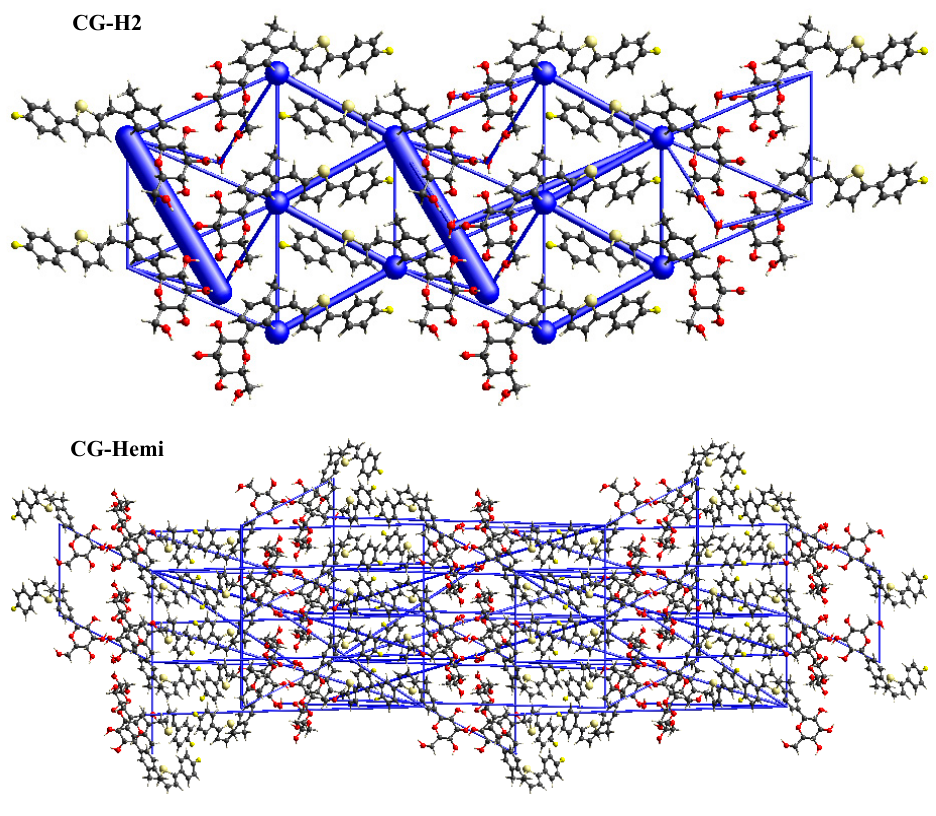
Figure 7. Total energy frameworks diagram of CG-H 2 O and CG-Hemi.